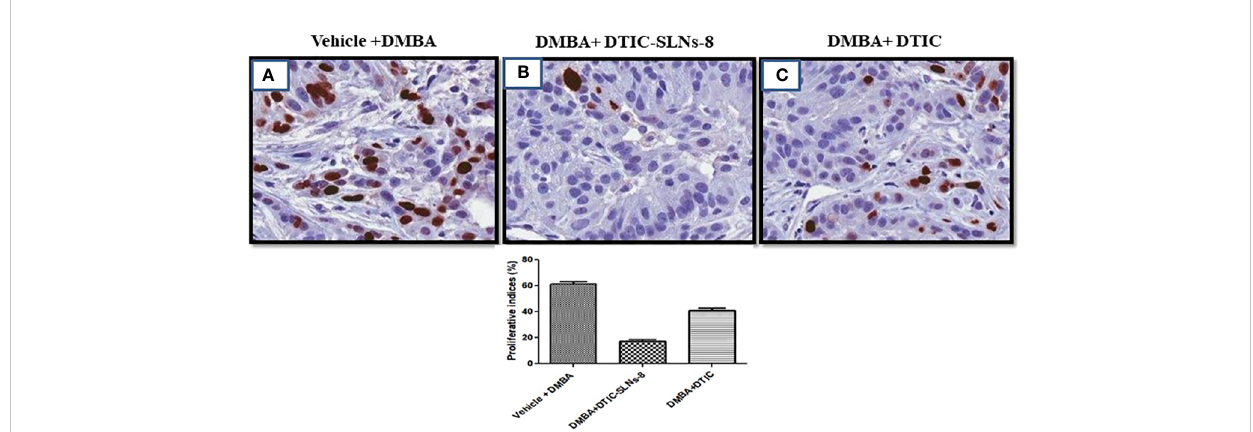
FIGURE 9 (A) represents overexpression of Ki-67 in DMBA treated group. (B) indicating DMBA+DTIC-SLNs-8 decreases proliferative cells in the tumor section in DMBA-induced skin tumors. (C) representing the moderate downregulation of Ki-67 expression. Representative images micrographs of Ki-67 staining (nuclei stained with brown color) in the tumor section of experimental groups are shown. Bar graph is shown the percentage of proliferative cells by counting Ki-67 positive cells in 15 randomly selected microscopic (40× objective) fi elds in each group were calculated by the total number of cells divided by the number of Ki-67 positive cells. vehicle Control treated group; DMBA treated group; DMBA+ DTIC-SLNs-8 with Gellan gum (0.01%w/v); DMBA+DTIC with Gellan gum (0.01%w/v) Statistical analyses were performed with Student ’ s t-test *p < 0.01 compared with DMBA alone treated